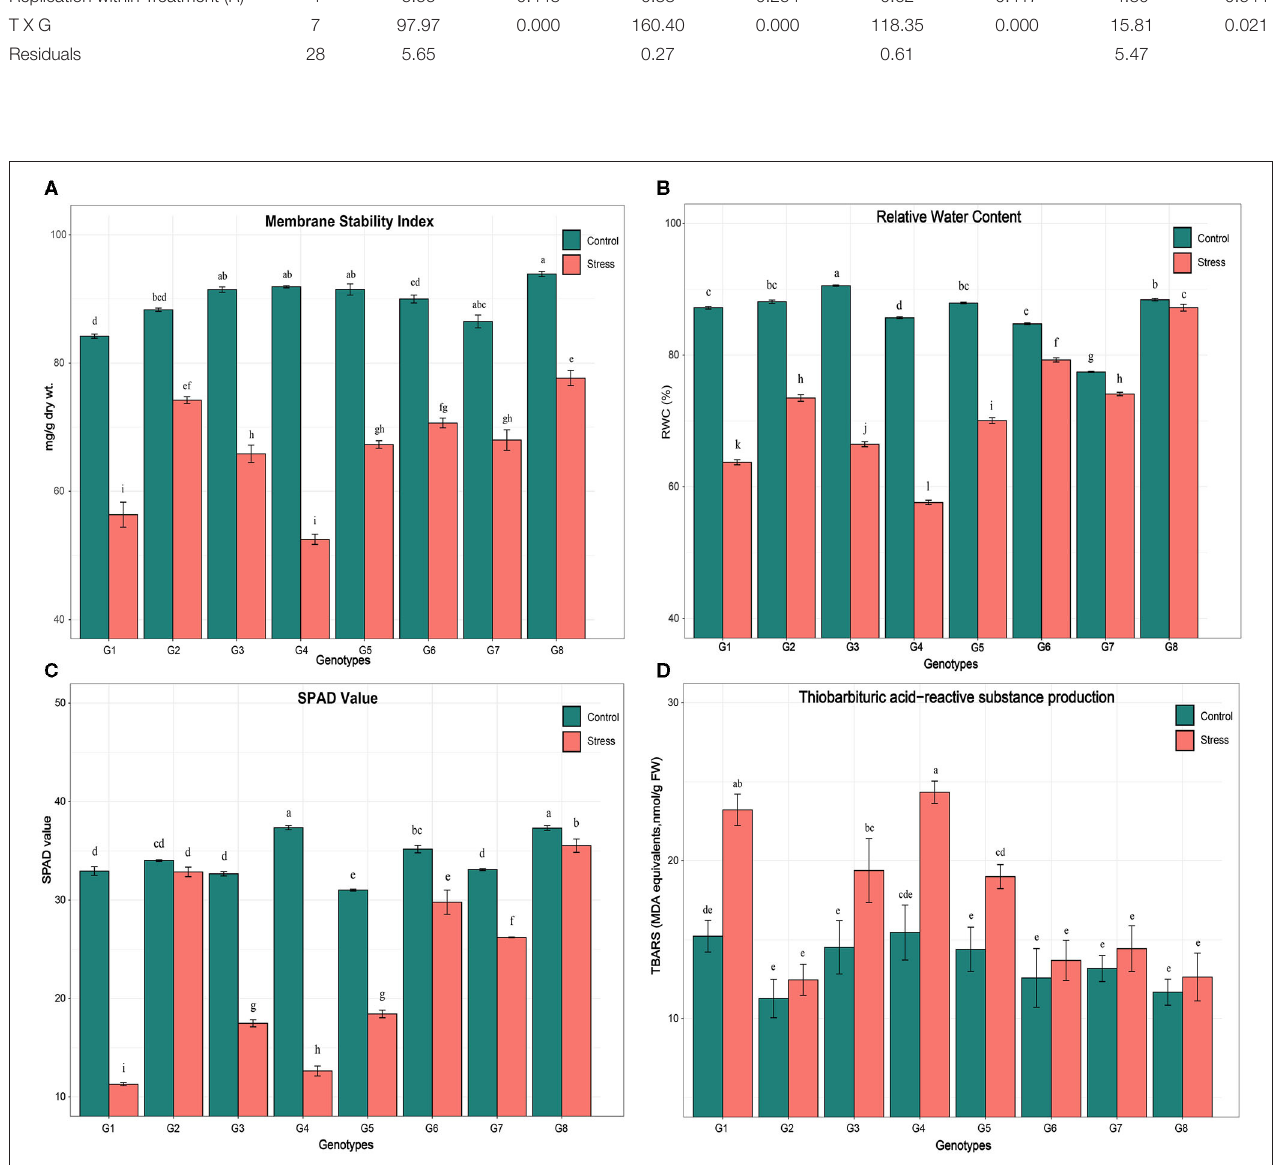
FIGURE 1 | Effect of heat stress on (A) membrane stability index (MSI), (B) relative water content (RWC), (C) chlorophyll meter value (SPAD), (D) thiobarbaturtic acid-reactive substance level on eight pearl millet genotypes [MS 411B (G1), MS 841B (G2), D-23 (G3), PPMI-69 (G4), PPMI-301 (G5), TT-1 (G6), TT-6 (G7), and WGI-126 (G8)]. Mean value followed by the different alphabets for a parameter in different genotypes and treatments indicates a significant difference at p ≤ 0.05. Vertical bars show mean ± SE (https://figshare.com/s/dea2659a099b4158896c).